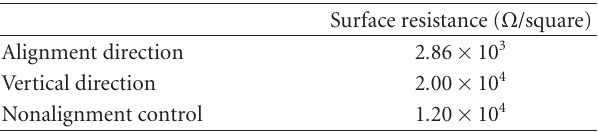
Figure 5: SEM image of CNT-composite paper ((a) low magnifi- cation and (b) high magnification). Dispersant was catechin. CNTs were aligned. Table 1: Surface resistance of CNT-composite paper with CNT density of 0.0568 mg/cm 2 (average for five